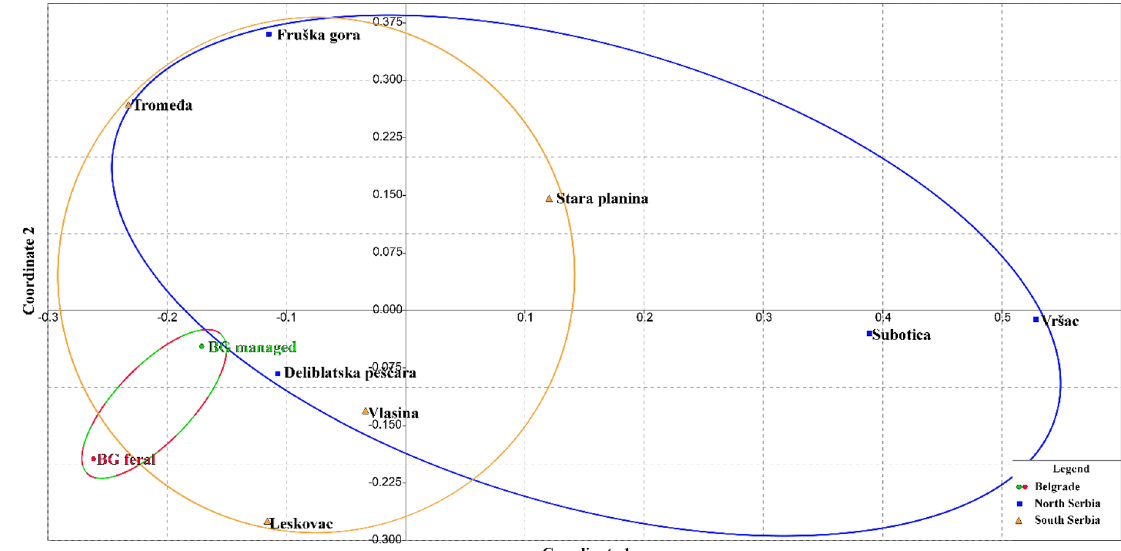
Figure 3. Non-metric multidimensional scaling plot of F ST distances between two types of honey bee colonies from Belgrade and honey bee colonies originating from different regions of Serbia based on the variability of tRNA leu -cox2 intergenic sequence. The goodness of fit is expressed with the stress value, which is 0.1120 for this data set. Population pairwise F ST values are presented in Suppl. Table S8.